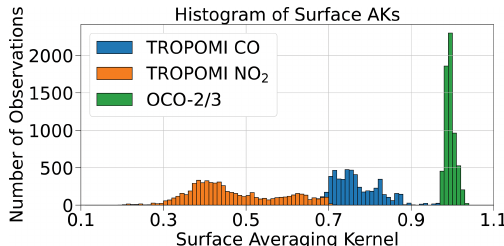
Figure 4. Example histograms of the averaging-kernel (AK) values at the surface pressure for OCO-2/3 and TROPOMI from all the data collected over Phoenix (USA), which are used to account for the sensitivity of the instruments to concentration changes at the